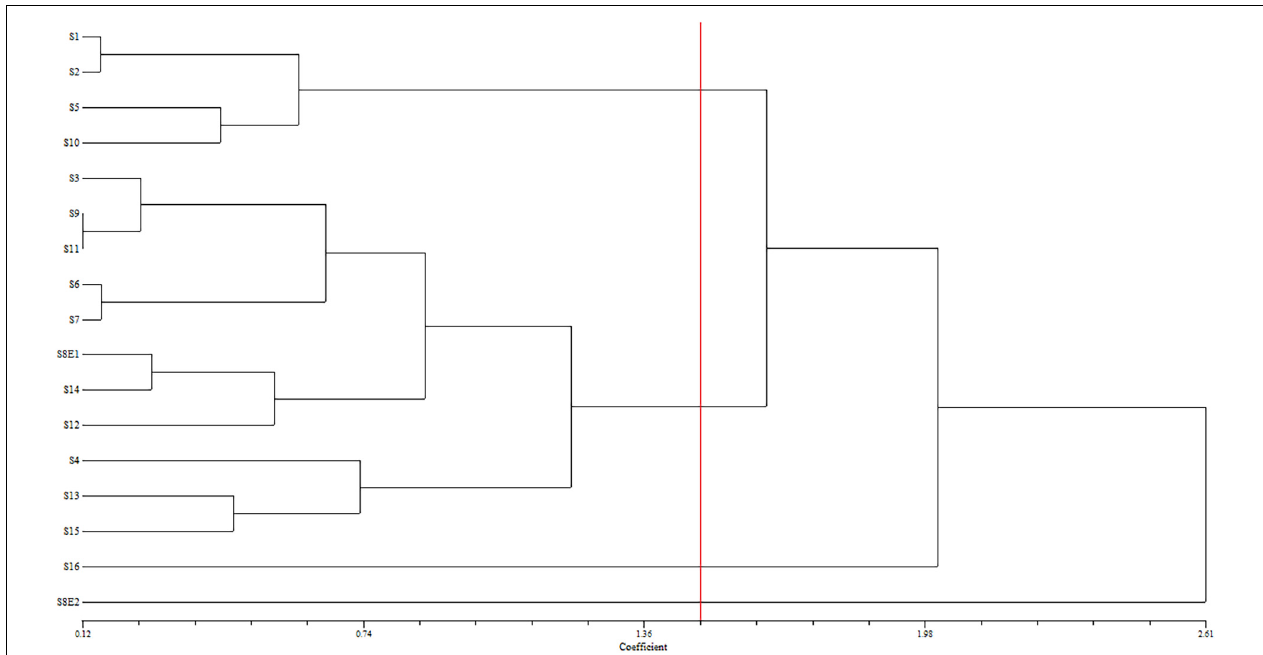
FIGURE 4 | Dendrogram showing the phenetic relationships among the examined populations of Pimpinella of 16 species, created using the matrix of karyotype similarities with UPGMA; cophenetic correlation r = 0.80. S1 ( P. affinis , x = 9), S2 ( P. eriocarpa , x = 9), S3 ( P. tragium , x = 10), S4 ( P. saxifrage , x = 10), S5 ( P. aurea , x = 10), S6 ( P. tragioides , x = 10), S7 ( P. olivieri , x = 10), S8 ( P. khayyamii , E1: x = 10; E2: x = 12), S9 ( P. kotschyana , x = 10), S10 ( P. deverroides , x = 10), S11 ( P. olivierioides , x = 10), S12 ( P. anthriscoides , x = 11), S13 ( P. anisactis , x = 11), S14 ( P. peucedanifolia , x = 11), S15 ( P. khorasanica , x = 11), and S16 ( P. rhodantha , x = 20).